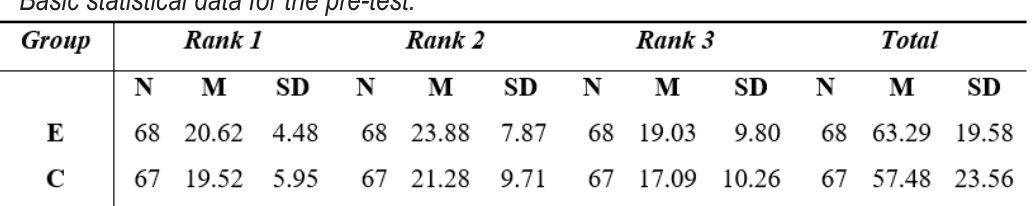
Basic statistical data for the